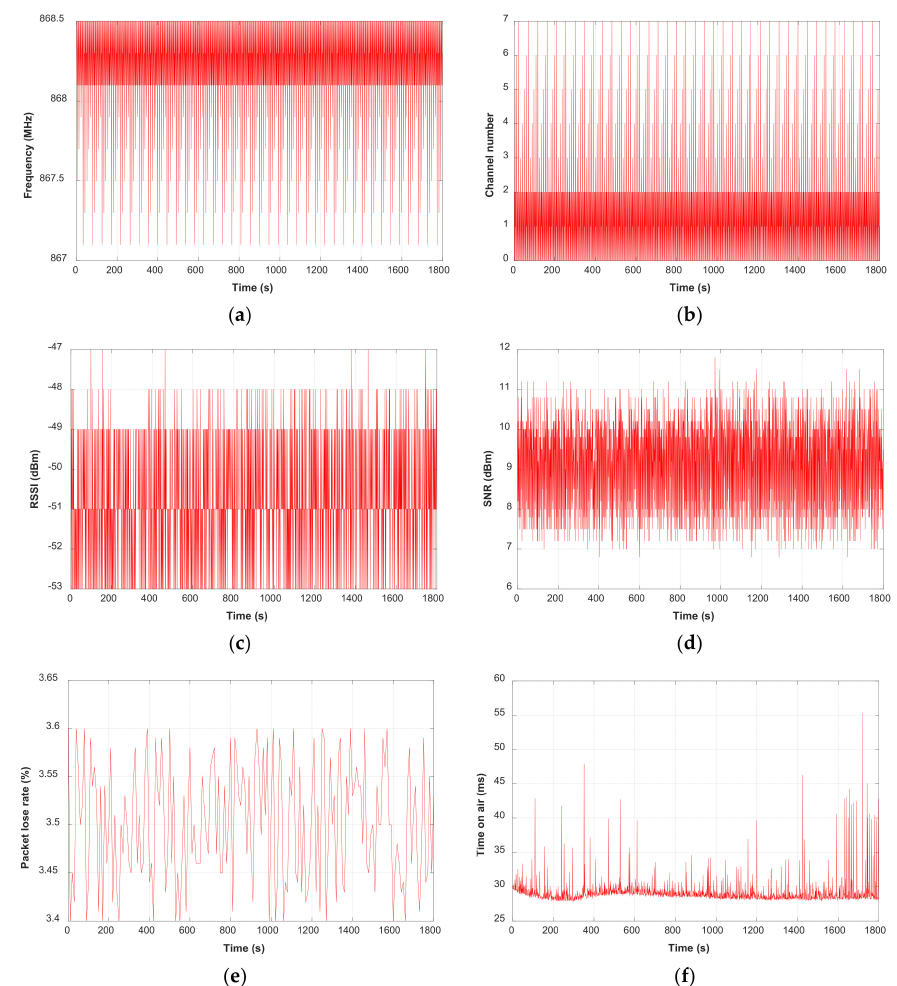
Figure 19. Measurements on the LoRa network: ( a ) frequency; ( b ) channel number; ( c ) RSSI; ( d ) SNR; ( e ) PLR; and ( f ) time on